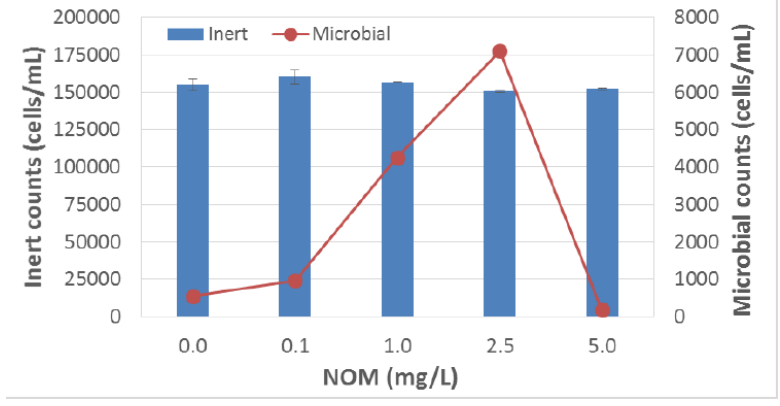
Figure 6. The Sensor B response to E. coli spiked (10 7 cfu/mL) in DI water containing Natural